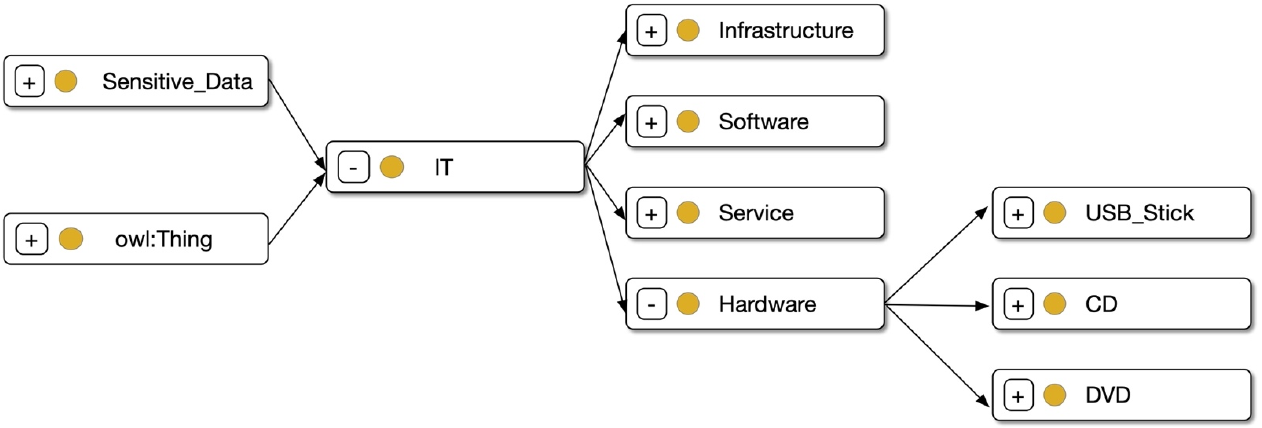
Figure 1. Excerpt of the CSE ontology.